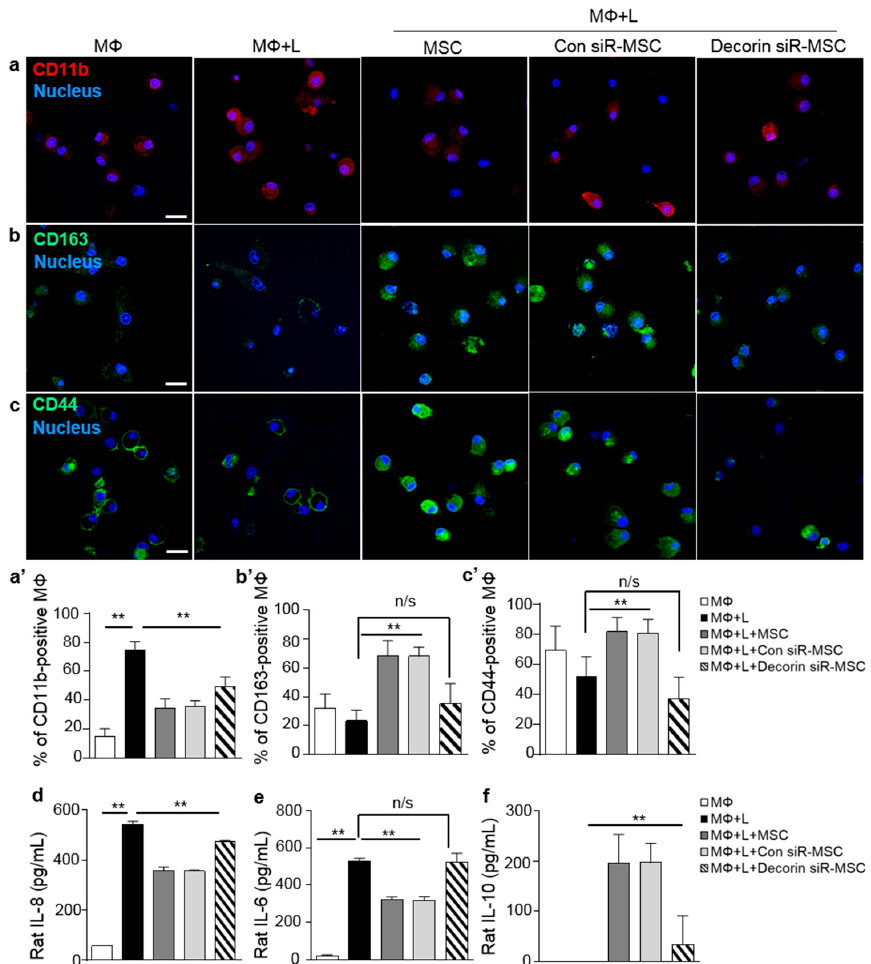
Figure 3. Decorin knockdown in MSCs attenuates macrophage polarization. ( a – c ) Decorin siRNA-treated MSCs were co-cultured with LPS-induced macrophages and macrophage polarization was assessed. ( a’ – c’ ) Immunofluorescent staining with CD11b, CD163, and CD44 were analyzed according to the percentage of positively stained cells. Red (CD11b) and green (CD163 and CD44) staining indicate positive cells. Nuclei were stained with Hoechst 33342. ( d ) IL-8, ( e ) IL-6, and ( f ) IL-10 levels in co-cultures of macrophages and MSCs were analyzed by ELISA. Data are presented as mean ± SD, n = 5 per group. Scale bar = 20 μ m. ** p < 0.01. n/s, not significant; M Φ , macrophage; L, LPS.